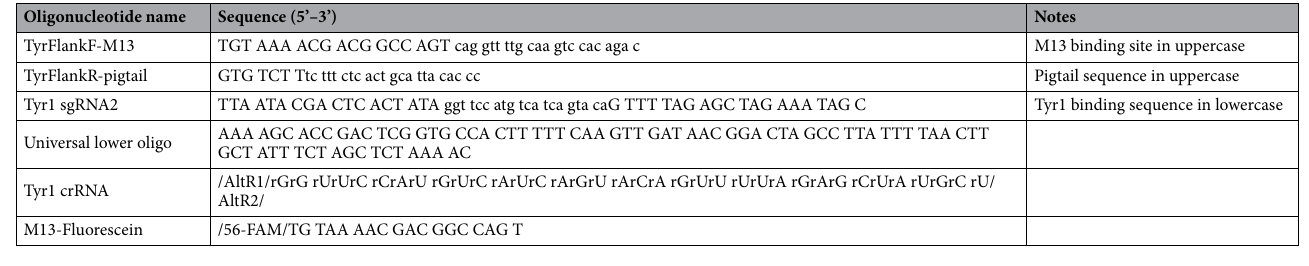
Table 1. Oligonucleotides used in the